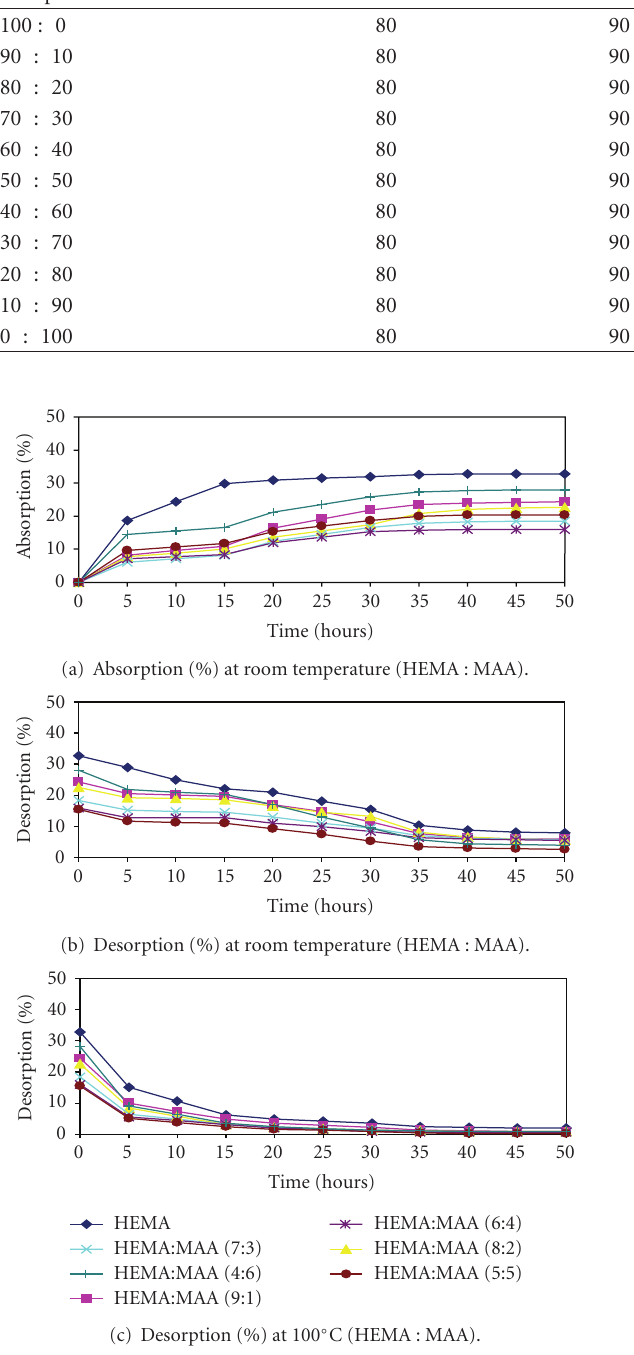
Figure 5: Studies on water absorption and desorption of polymers obtained with HEMA :